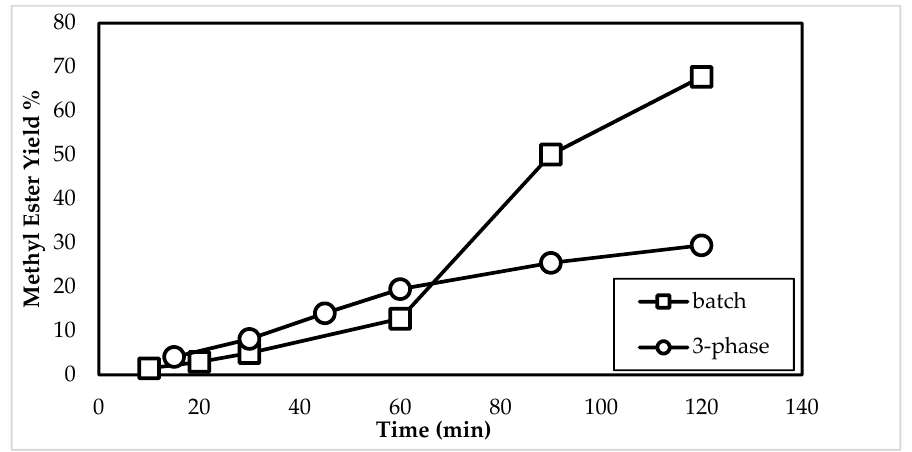
Figure 7. Comparison of methyl ester yields in the three-phase (90 °C) and conventional (60 °C) reactors.